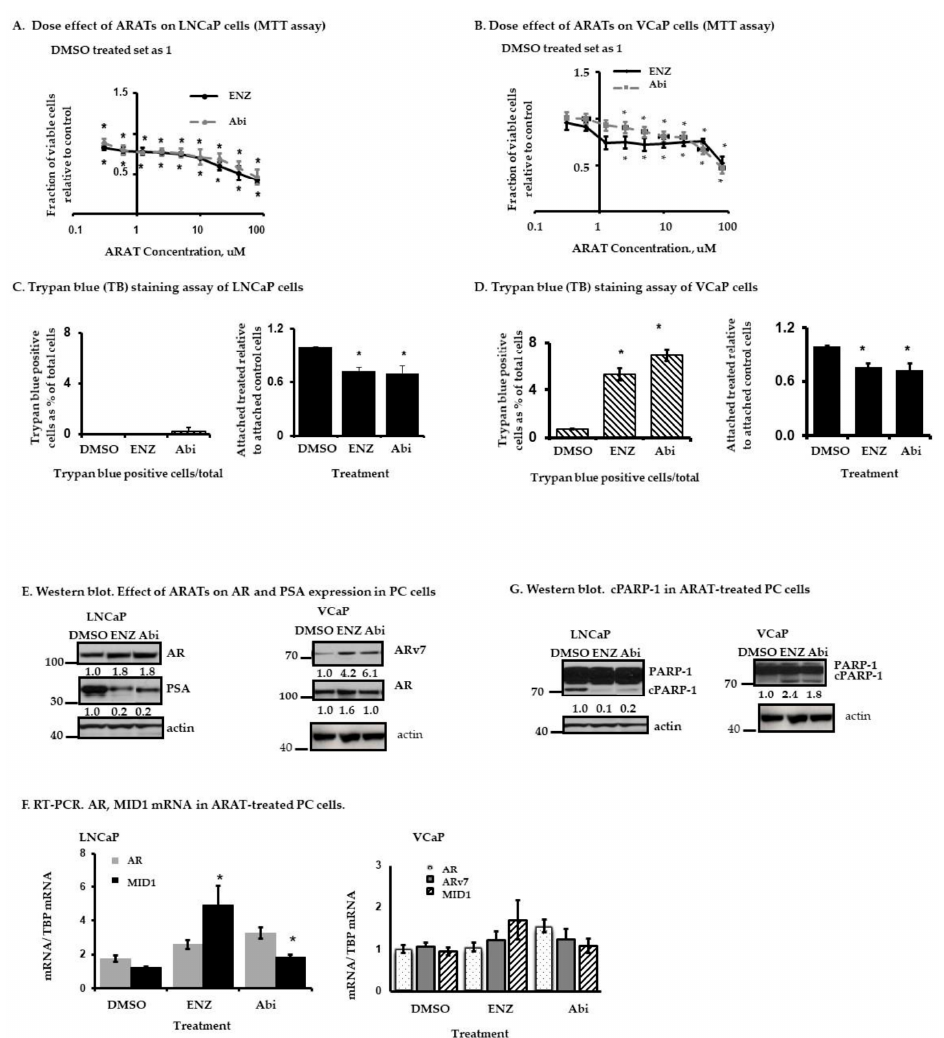
Figure 1. Effect of enzalutamide (Enz) and abiraterone (Abi) on LNCaP and VCaP cells. ( A , B ) 3-(4,5-dimethylthiazol-2-yl)- 2,5-diphenyltetrazolium bromide (MTT) assay. Cells were treated with increasing doses of Enz or Abi for 3 days. Shown are the fractions of viable treated cells relative to control (DMSO-treated) cells, as determined by MTT assay. Results represent the mean ± standard deviation (S.D.) from three separate experiments, each done with triplicate determinations per data point. (* p < 0.05), Student’s t -test. ( C , D ) Trypan blue staining. Cells were treated with Enz 10 µ M, Abi 5 µ M or DMSO (control) for 5 days and stained with trypan blue. Both floating and attached cells were collected. Floating cells generally represent dead cells (uniformly stained with trypan blue), while attached cells are not yet dead (exclude trypan blue). ( C ) Left. LNCaP floating cells are shown as a percentage of total treated cells (floating + attached) within each plate. Right. Drug-treated LNCaP attached cells are shown as a fraction of attached control (DMSO-treated) cells, which was set at 1. ( D ) Left. VCaP floating cells are shown as a percentage of total treated cells (floating + attached) within each plate. Right. Drug-treated VCaP attached cells as a fraction of attached control (DMSO-treated) cells, which was set at 1. Results represent the mean ± S.D. from three separate experiments, each done with triplicate determinations per data point. (* p < 0.05), Student’s t -test. ( E ) Western blot. Androgen receptor (AR), ARv7, and prostate serum antigen (PSA) expression in PC cells treated with Enz 10 µ M or Abi 5 µ M for 5 days. ( F ) RT-PCR. Relative AR, ARv7, and MID1 mRNA expression in 5 day-treated PC cells. The specific mRNAs were normalized with the respective TATA-box-binding protein (TBP) mRNA in the drug-treated or DMSO (control)-treated cells. Results represent the mean ± S.D. from three separate experiments, each done with duplicate determinations per data point. (* p < 0.05), Student’s t -test. ( G ) Western blot. PARP-1 and cPARP-1 expression in PC cells treated for 5 days with Enz or Abi. Results are representative of two separate experiments. The original western blot figures are available in a separate Supplementary Materials document. In ( E ) and ( G ), the actin loading controls for the respective LNCaP and VCaP western blots are identical since they are part of the same original blots probed with different antibodies of interest; the figures are organized as shown to better align with the data presented in the Results